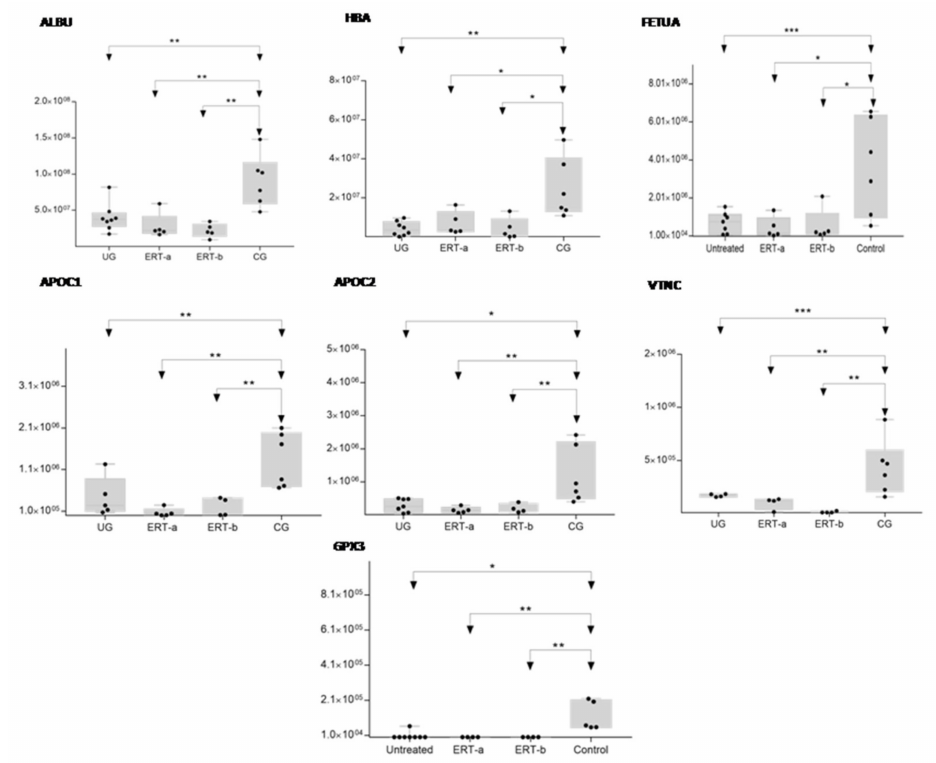
Figure 9. Box plot depicting expression levels of the6 most relevant plasma proteins (ALBU, HBA, FETUA, APOC1, APOC2, VTNC, and GPX3) for which downregulation was observed in the UG and ERT-a and ERT-b groups relative to the control group (CG). Each data point represents the median protein expression value obtained in an individual sample. The line inside the box represents the median of all values obtained. The upper and lower limits of the box represent the first and third quartiles. Whiskers represent the minimum and maximum values within 1.5 times the interquartile range. Any data points not included between the whiskers are considered outliers. * p < 0.05; ** p < 0.01; *** p < 0.001.